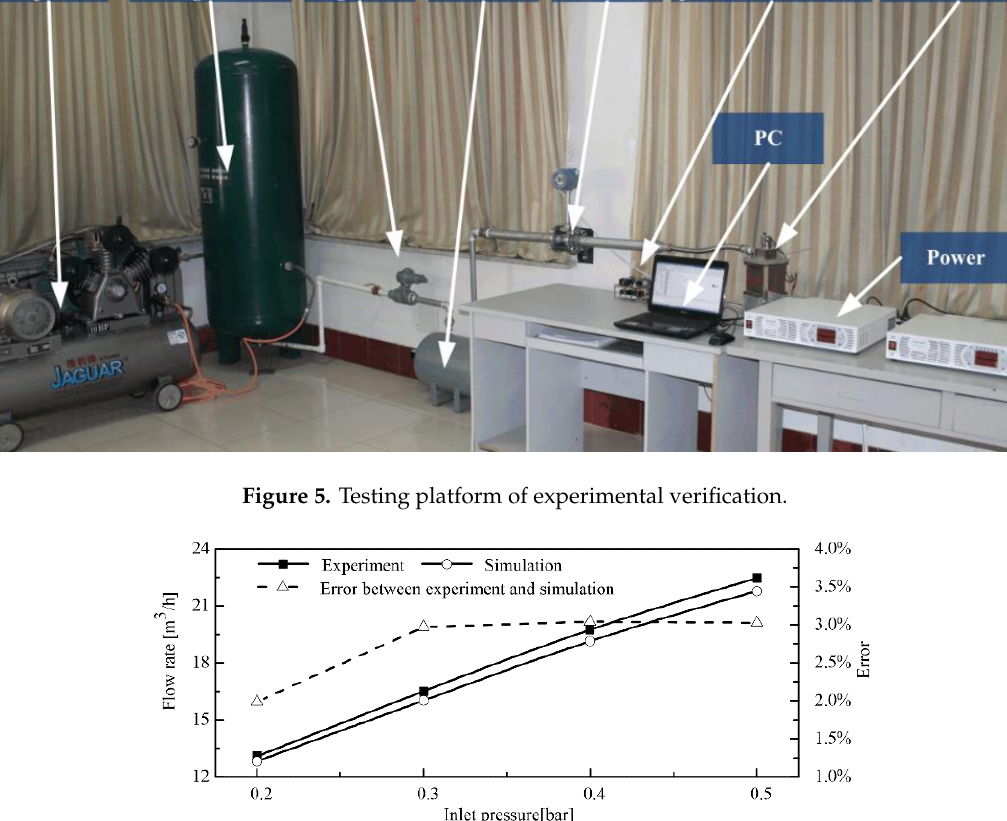
Figure 6. Comparison of the results of experiment and CFD simulation.